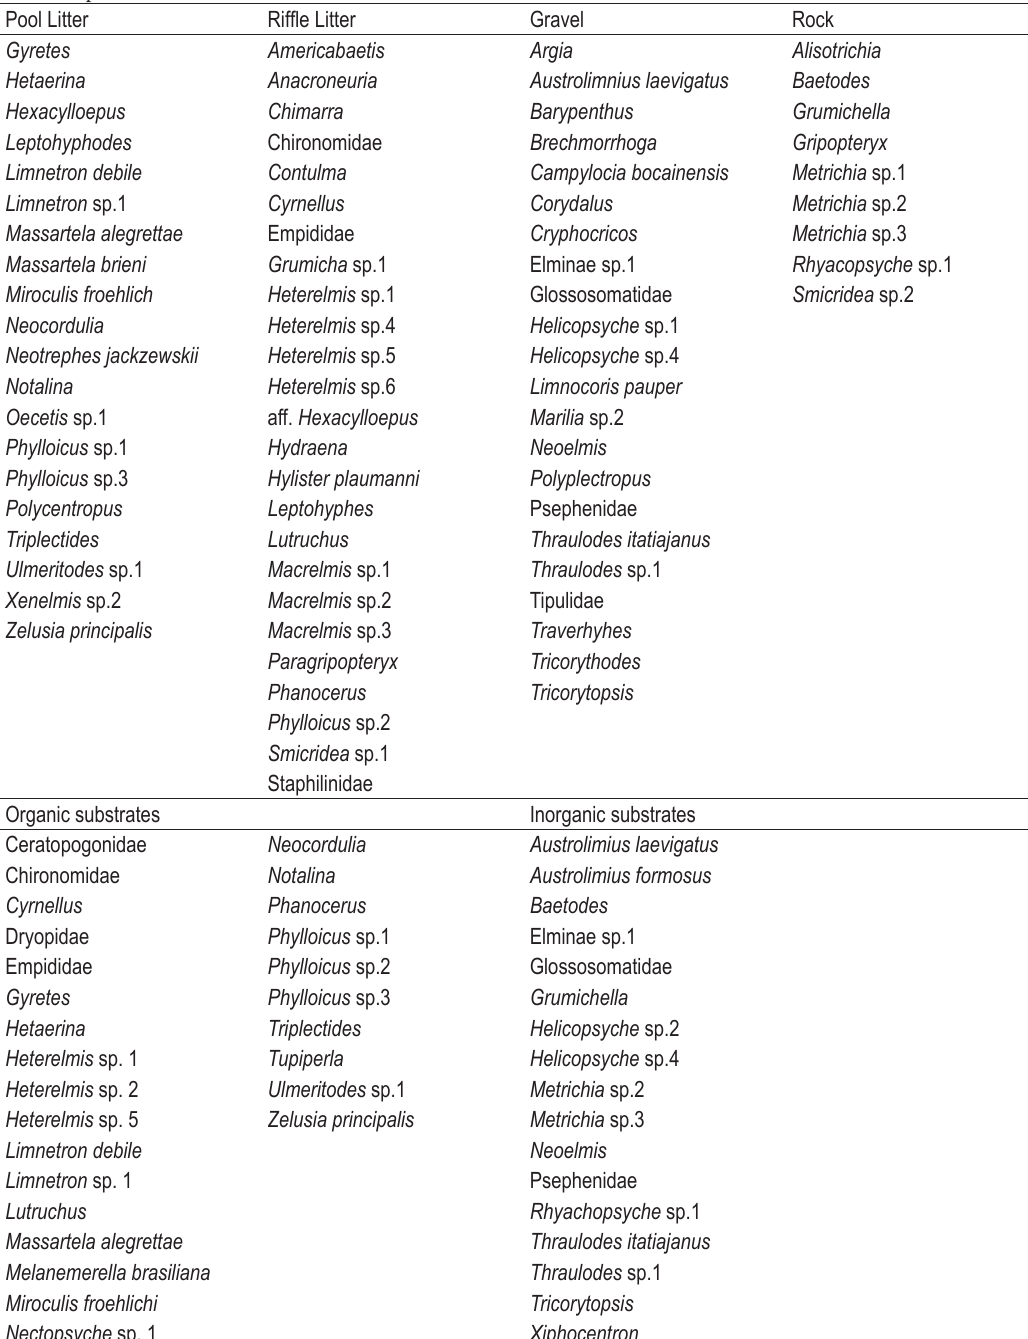
Table 3. Taxa indicators found to each substrate type and organic/inorganic susbtrates found at the Serra da Bocaina streams. (p <